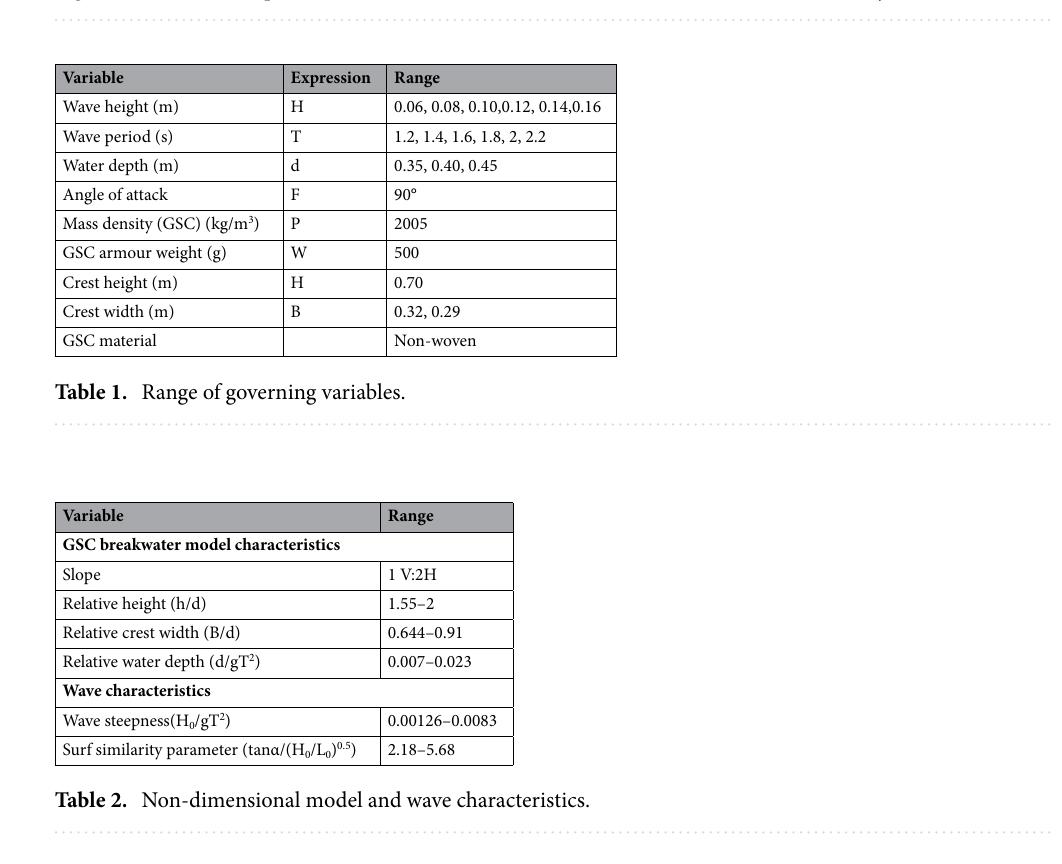
Figure 1. Schematic representation of GSC breakwater model at Wave Mechanics Laboratory, NITK 26 .